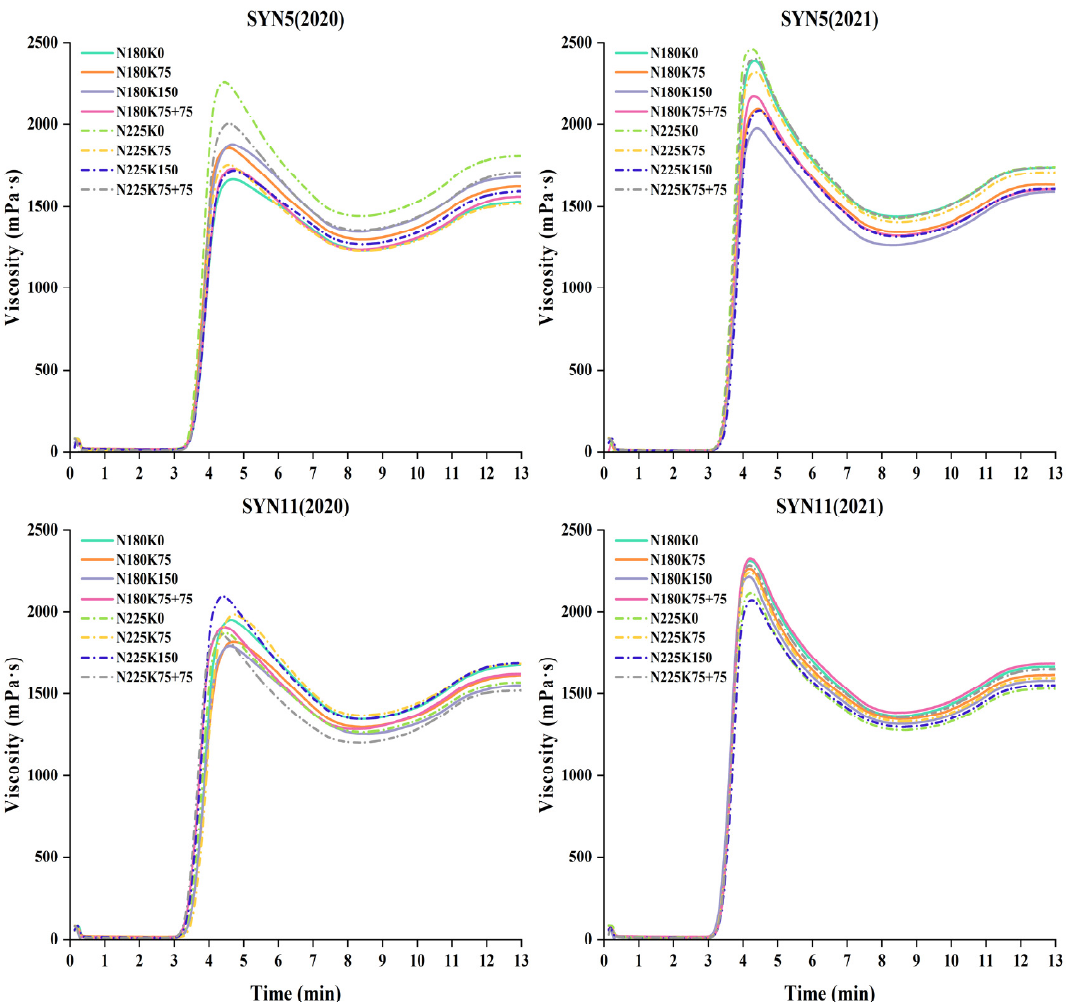
Figure 2. Pasting properties of waxy maize under different fertilization treatments. N180, N225: application 180 and 225 kg N ha − 1 ; K0, K75, K150: application 0, 75 and 150 kg K 2 O ha − 1 at sowing date; K75 + 75: application 75 kg K 2 O ha − 1 at sowing date and jointing stage (V6), respectively. The figure shows the mean values of three replicates of the same